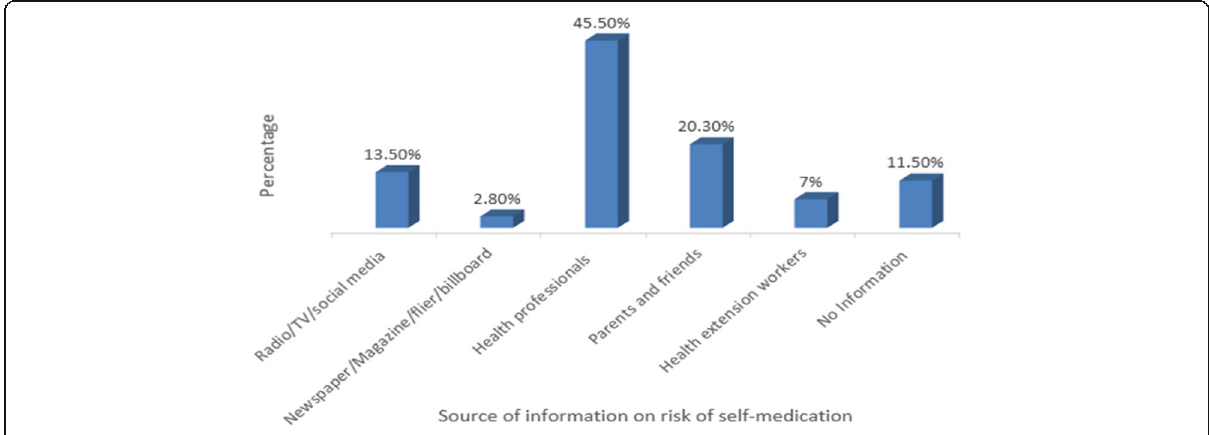
Fig. 2 Source of information on risk self-medication during pregnancy, 2017 ( n = 617)